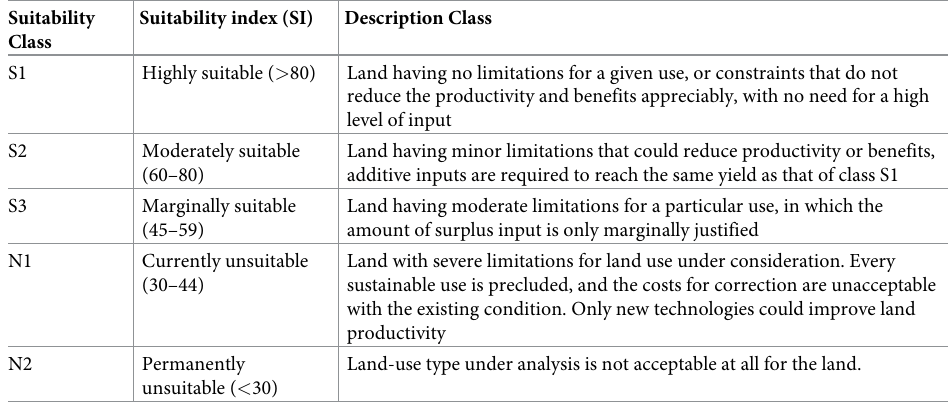
Table 5. Suitability indices for the different suitability classes